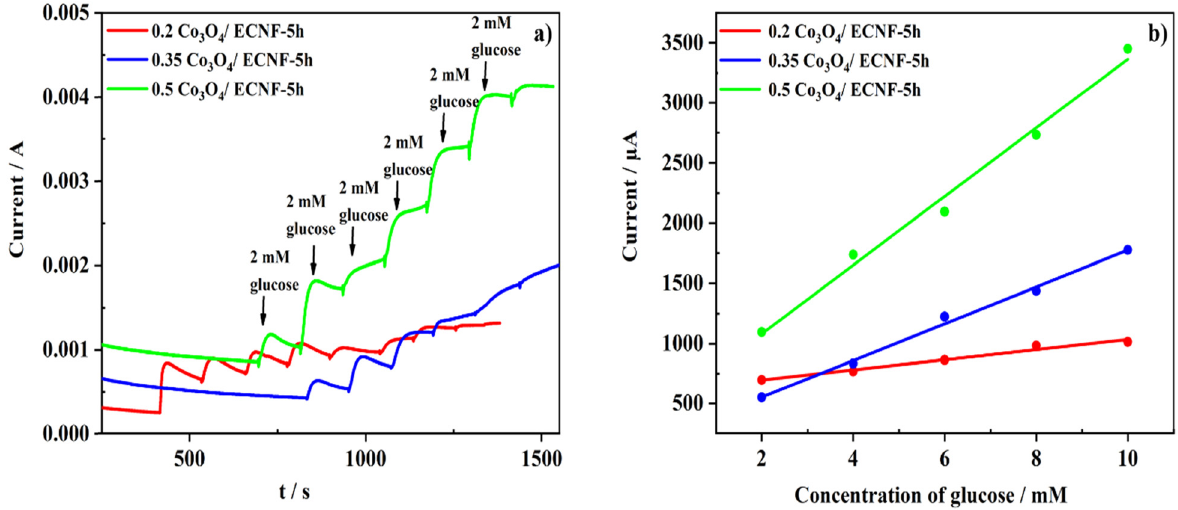
Figure 7: ( a ) CA plots of the Co 3 O 4 /ECNF electrodes with di ff erent concentrations of glucose in 0.1 M NaOH solution recorded at + 0.55 V, and ( b ) calibration curves of the electrodes.